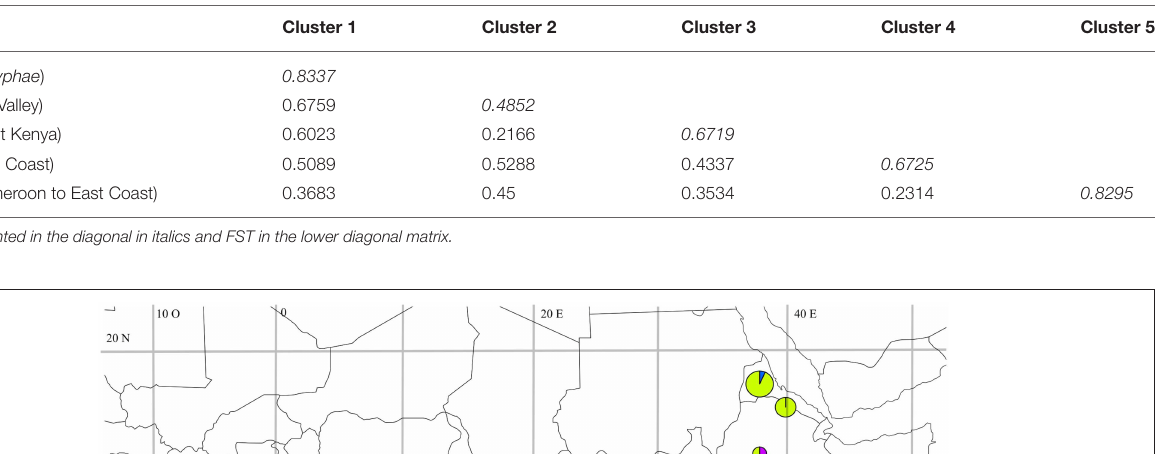
Frontiers in Ecology and Evolution |